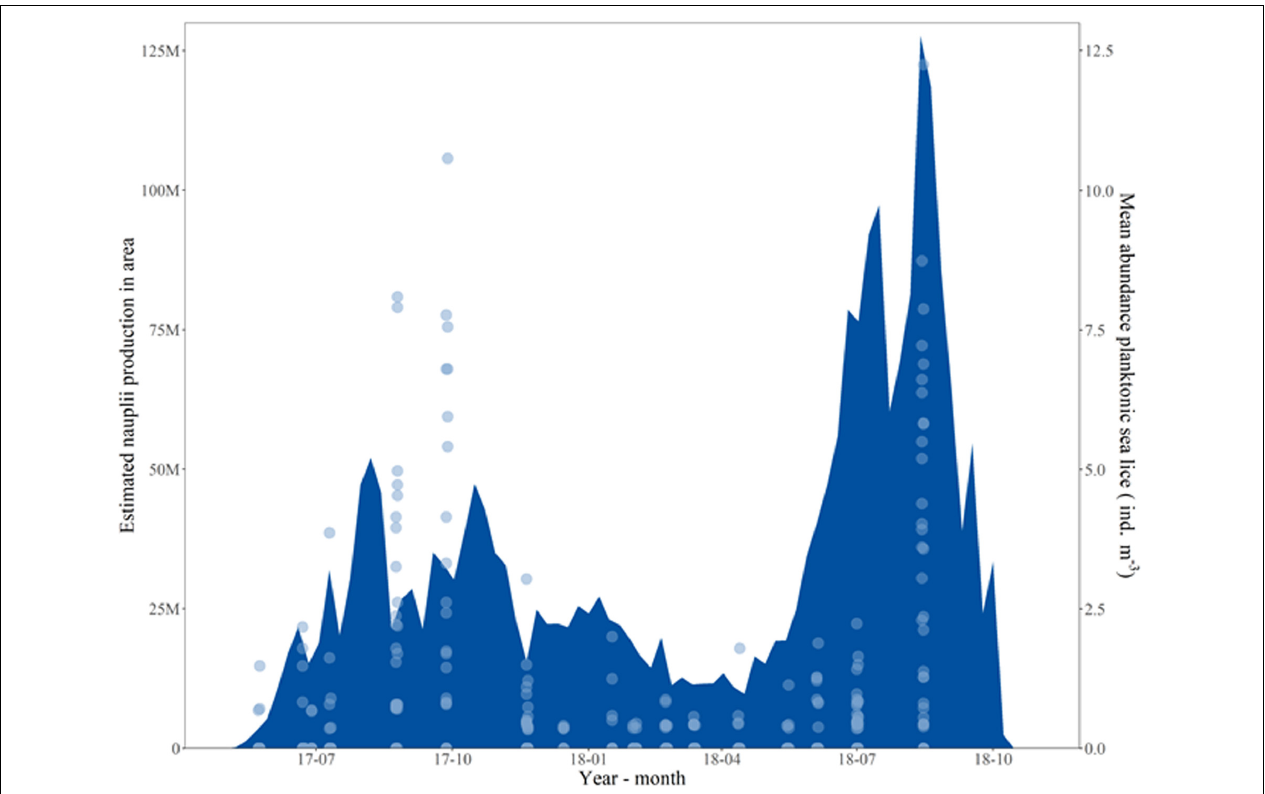
FIGURE 7 | Predicted Lepeophtheirus salmonis nauplius production (individuals day − 1 ) in the study area (blue field, M = million) and mean abundance of planktonic sea lice (individuals m − 3 ) found inside and outside of each cage (light blue circles). Nauplii predictions are based on Equations 1–3 in Stucchi et al. (2011), with coefficients suggested by Stien et al.